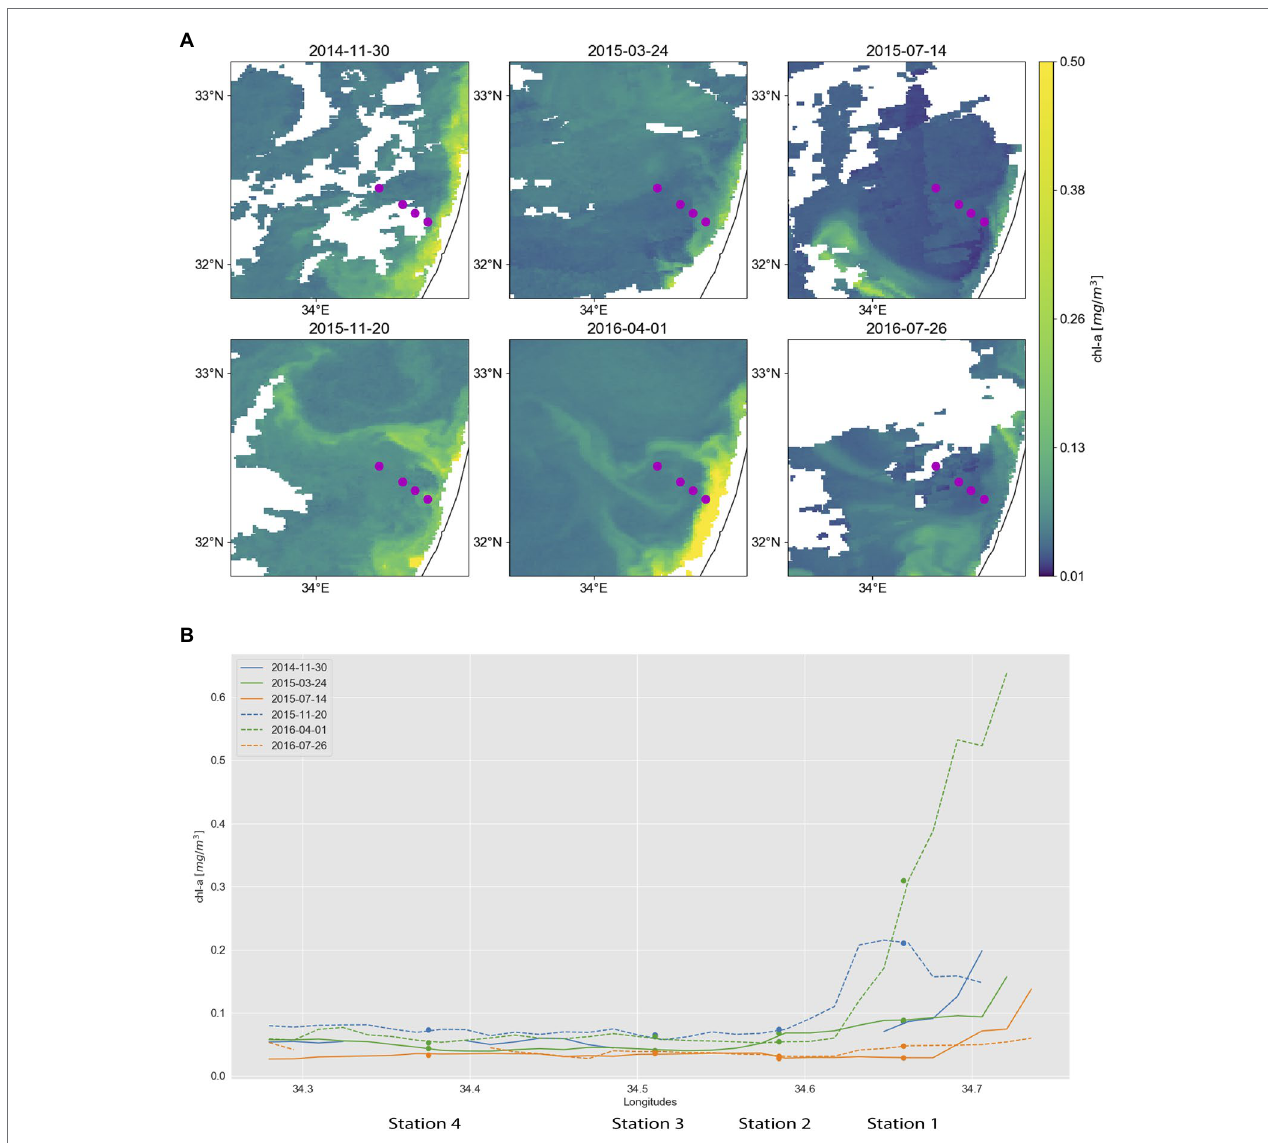
FIGURE 1 | Surface chlorophyll concentrations in the southeastern Mediterranean. Dots mark locations of sampling stations, which are from right (coast) to left (offshore): Station 1, 2, 3, and 4. (A) Maps derived from Copernicus Marine Environment Monitoring Service (CMEMS) merged satellite data. Purple dots mark the locations of sampling stations. (B) Surface chlorophyll concentrations along a coast-to-open-sea transect overlapping the sampling stations. The transects are derived from the multi-satellite chlorophyll maps shown in A, with each line corresponding to a different sampling date. To reduce the area masked by clouds, chlorophyll maps from 30.11.2014, 20.11.2015, 01.04.2016, and 26.07.2016 were used instead of 01.12.2014, 17.11.2015, 30.03.2016, and 25.07.2016, respectively. Furthermore, maps for 30.11.2014, 24.3.2015, 14.7.2015, and 26.7.2016 are composed of 5, 3, 3, and 3 consecutive images,